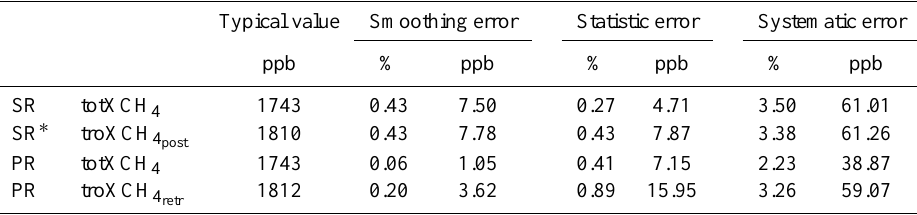
Table 4. Total errors estimated for typical measurement conditions (16 June 2010). Typical value Smoothing error Statistic error Systematic error ppb